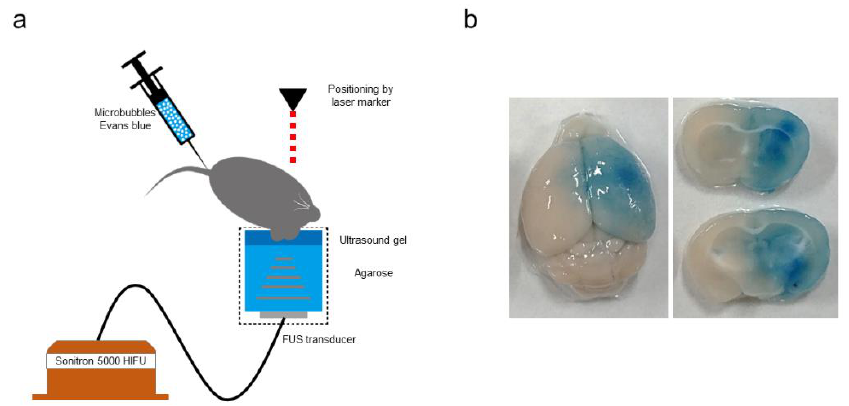
Figure 5. Focused ultrasound (FUS)/microbubble-assisted blood-brain barrier (BBB) opening system. ( a ) Schematic of the experimental setup for BBB opening. The cylindrical FUS transducer was filled with agarose and ultrasound gel. The mouse was placed in the supine position, and the head positioned on ultrasound gel. The irradiation target region in the mouse brain was adjusted using a laser marking device. Then, FUS (frequency, 3 MHz; intensity, 1.5 kW/cm 2 ; duration, 60 s; duty cycle, 5% [1 msec irradiation and 19 msec interval]) was applied to the right striatum after intravenous administration of microbubbles and Evans blue. ( b ) BBB opening confirmed using Evans blue